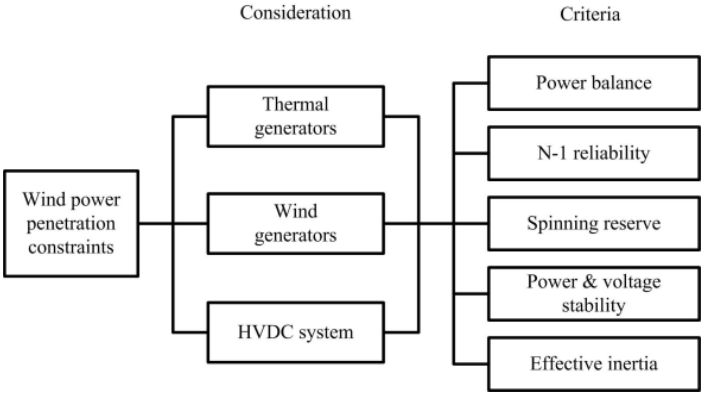
Figure 1. Criteria of the wind power generation constraints.